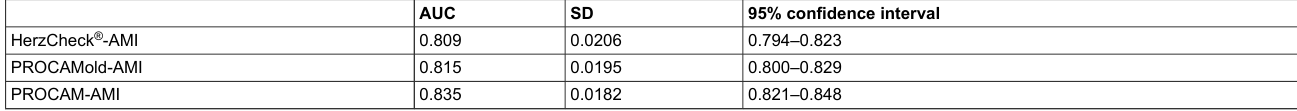
Table 4: Discrimination (ROC analysis) comparison of HerzCheck, PROCAMold and PROCAM to detect primary outcome (AMI + STR + CABG). AUC SD